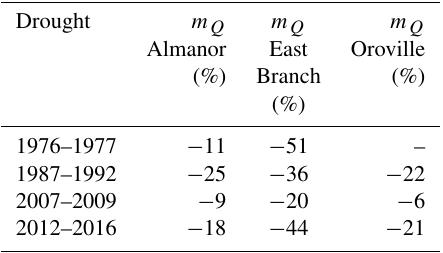
Table 2. Estimated shift in the precipitation–runoff relationship for single droughts on the Feather River (see Sect.